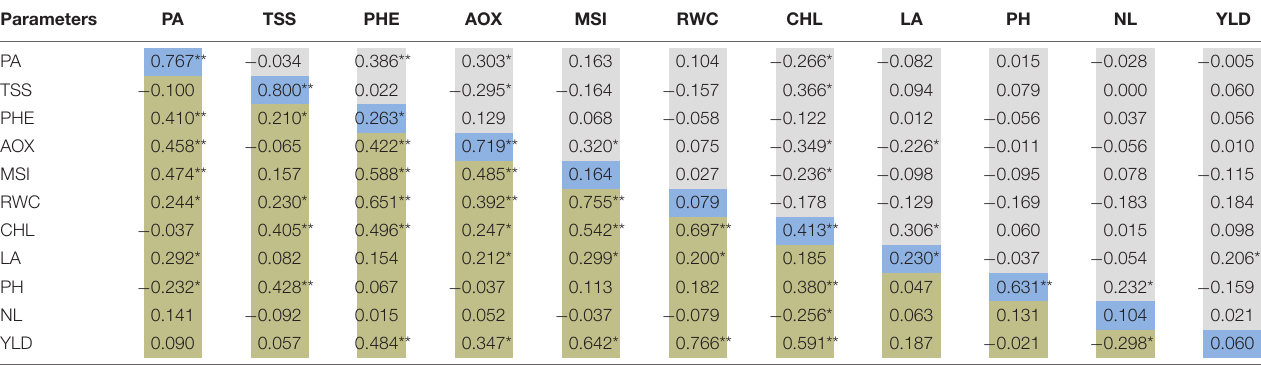
TABLE 4 | Pearson’s correlation matrix among the physiological and yield traits under well-water (Upper diagonal) and water-deficit stress condition (Lower diagonal). Parameters